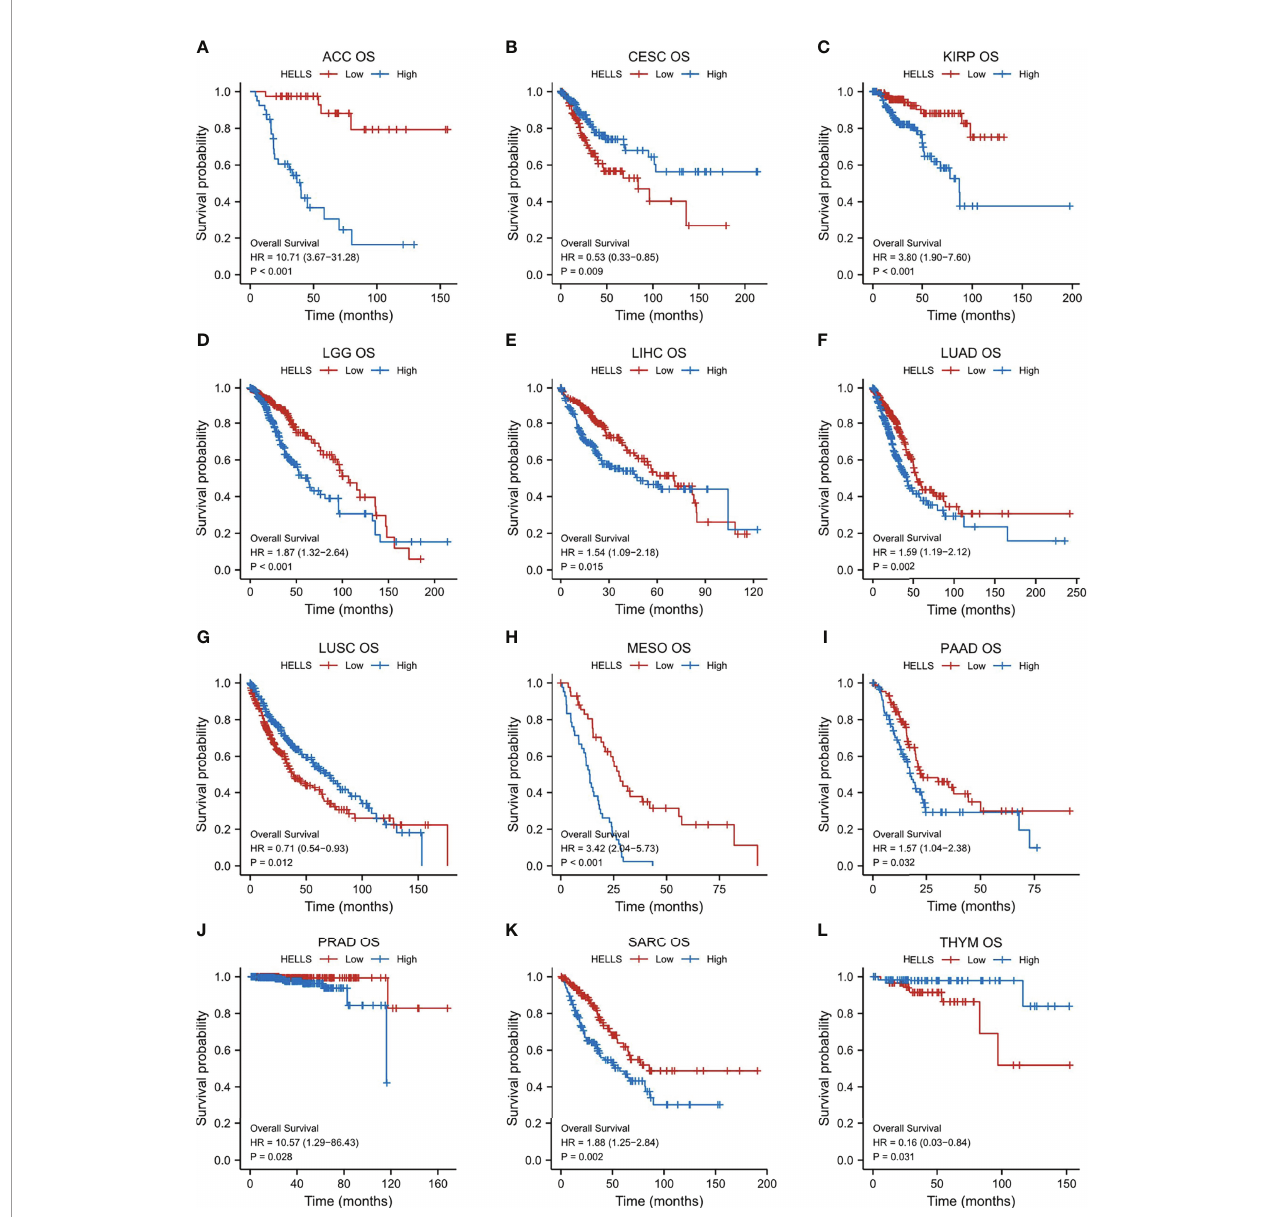
FIGURE 5 | Correlations between HELLS and prognosis in 12 cancers. OS K-M curve for HELLS in 12 cancers. The unit of X-axis is month. (A) ACC, (B) CESC, (C) KIRP, (D) LGG, (E) LIHC, (F) LUAD, (G) LUSC, (H) MESO, (I) PAAD, (J) PRAD, (K) SARC, (L)